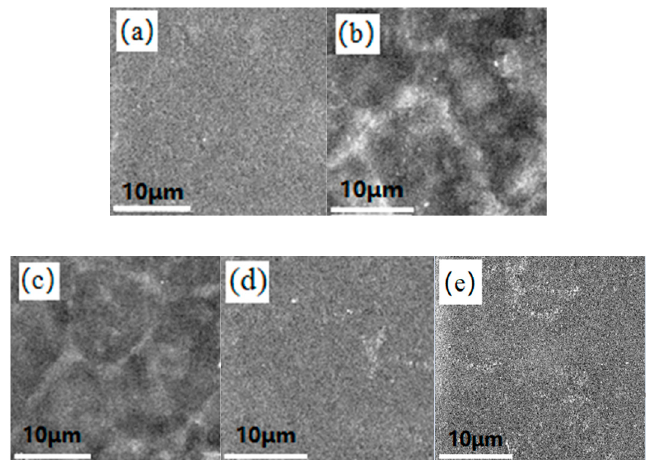
Figure 6. SEM micrographs of the composite films with various dosages of ZnO NPs: ( a ) 1%, ( b ) 3%, ( c ) 5%, ( d ) 7% and ( e ) 9% with 2 wt % carboxy methyl cellulose on a dry starch basis. The SEM magnification is × 2000.